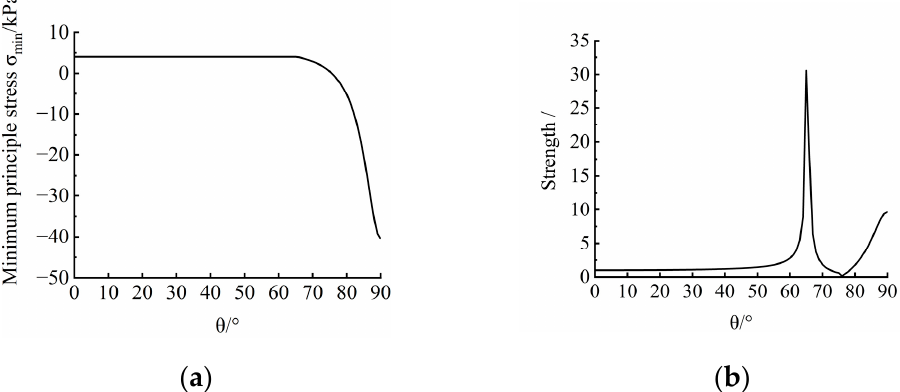
Figure 10. Phase II ( β ≈ 60 ◦ ). ( a ) Distribution of minimum principal stress; ( b ) distribution of strength.